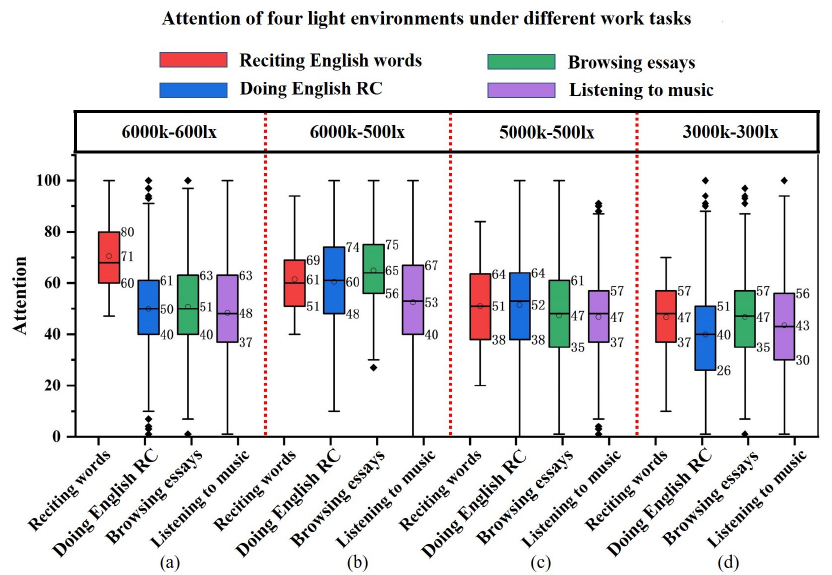
Figure 21. Box plot: attention of four light environments under different work tasks, including ( a ) 6000 k–600 lx, ( b ) 6000 k–500 lx, ( c ) 5000 k–500 lx and ( d ) 3000 k–300 lx.